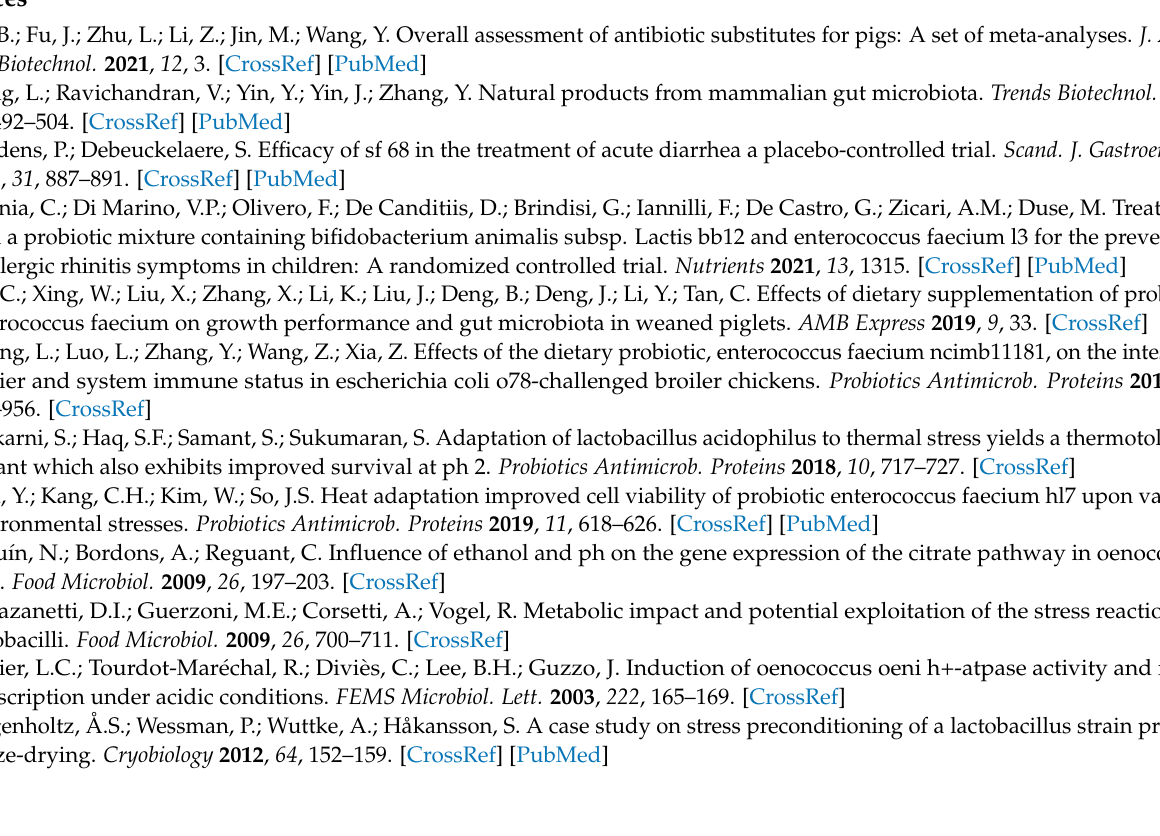
Table S2: The mutant genes for WT RS047 and RS047-wl. Table S3: Major DEGs of the WT RS047 and RS047-wl that can be identified by NCBI. Table S4: Major differential metabolites detected by using HMDB (Human metabolome database) and Metlin